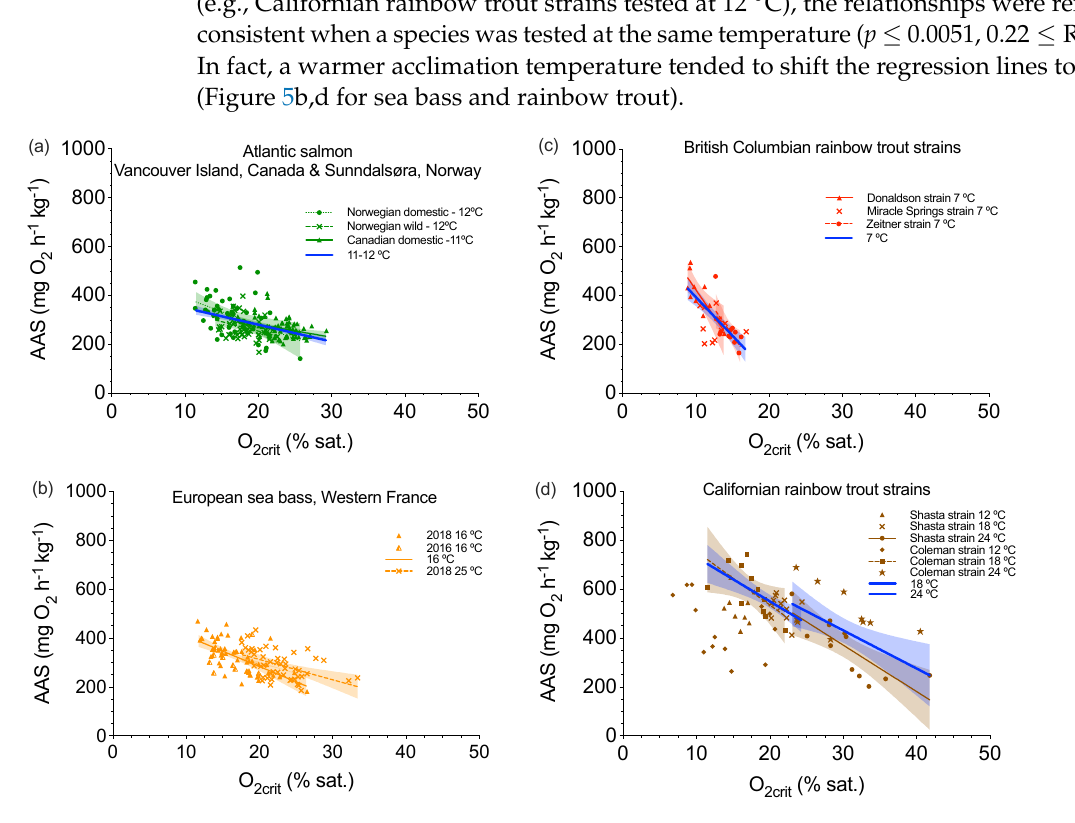
Figure 5. Linear regression (mean ± 95% C.I.) for critical dissolved oxygen (O 2crit ) and absolute aerobic scope (AAS) in three athletic fish species. The two hallmarks of hypoxia performance curve, O 2crit and AAS, were measured on the same set of individuals for Atlantic salmon ( Salmo salar ) at Vancouver Island, Canada, and Sunndalsøra, Norway ( a ), European sea bass ( Dicentrarchus labrax ), Western France, ( b ) rainbow trout ( Oncorhynchus mykiss ) strains at British Columbia, Canada ( c ) and California, United States ( d ). Geographic locations are separated by different colours. Testing groups are separated by different symbols within a species. Significant linear regressions are labeled (lines) for Donaldson strain at 7 ◦ C (y = − 43.8x + 863.1, p = 0.0065, R 2 = 0.63), Zeitner strain at 7 ◦ C (y = − 43.4x+ 889.7, p = 0.016, R 2 = 0.45), Shasta strain at 24 ◦ C (y = − 19.0x + 940.7, p = 0.0019, R 2 = 0.64), Coleman strain at 18 ◦ C (y = − 21.8x + 971.9, p = 0.042, R 2 = 0.38), European sea bass at 16 ◦ C, pooled 2016 and 2018 (y = − 12.5x + 534.4, p < 0.0001, R 2 = 0.38), Norwegian domestic Atlantic salmon at 12 ◦ C (y = − 7.8x + 409.8, p = 0.013, R 2 = 0.14), Norwegian wild Atlantic salmon at 12 ◦ C (y = − 11.2x + 502.1, p = 0.0032, R 2 = 0.18), and Canadian domestic Atlantic salmon at 11 ◦ C (y = − 5.2x + 385.2, p = 0.0012, R 2 = 0.13). The figure legends without a regression line mean no relationship in some testing groups: Miracle Spring strain at 11 ◦ C (y = − 6.3x + 358.4, p = 0.58, R 2 = 0.63), Shasta strain at 12 ◦ C (Y = − 5.7x + 614.7, p = 0.49, R 2 = 0.062), Shasta strain at 18 ◦ C (y = − 14.0x + 826.5, p = 0.19, R 2 = 0.15), Coleman strain at 12 ◦ C (y = − 10.1x + 585.7, p = 0.18, R 2 = 0.16), Coleman strain at 24 ◦ C (y = − 10.1x + 816.9, p = 0.13, R 2 = 0.30). Furthermore, the species tested under the similar temperature ( ± 1 ◦ C) are pooled (significant regression lines were denoted) for British Columbia rainbow trout at 7 ◦ C (y = − 5.2x + 385.2, p = 0.0012, R 2 = 0.13), Atlantic salmon at 11–12 ◦ C (y = − 6.9x + 419.0, p < 0.0001, R 2 = 0.22), European sea bass at 16 ◦ C (y = − 13.8x + 561.0, p < 0.0001, R 2 = 0.48) and 25 ◦ C (y = − 8.3x + 478.6, p = 0.0004, R 2 = 0.24), and Californian rainbow trout at 18 ◦ C (y = − 18.0x + 909.8, p = 0.0003, R 2 = 0.45) and 24 ◦ C (y = − 15.6x + 898.4, p = 0.0051, R 2 = 0.34), but not 12 ◦ C (y = − 4.9x + 551.4, p = 0.37, R 2 =